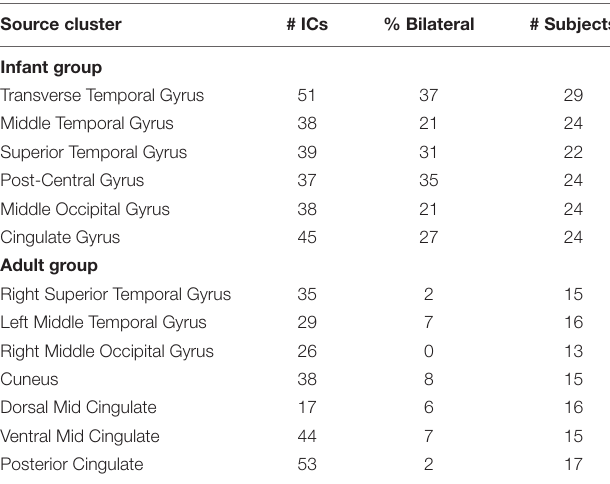
TABLE 1 | The number of independent components (ICs), percentage of bilateral ICs, and number of subjects contributing to each of the six bilateral clusters for the infant group (upper panel) and to each similarly located cluster in the adult group (lower panel).